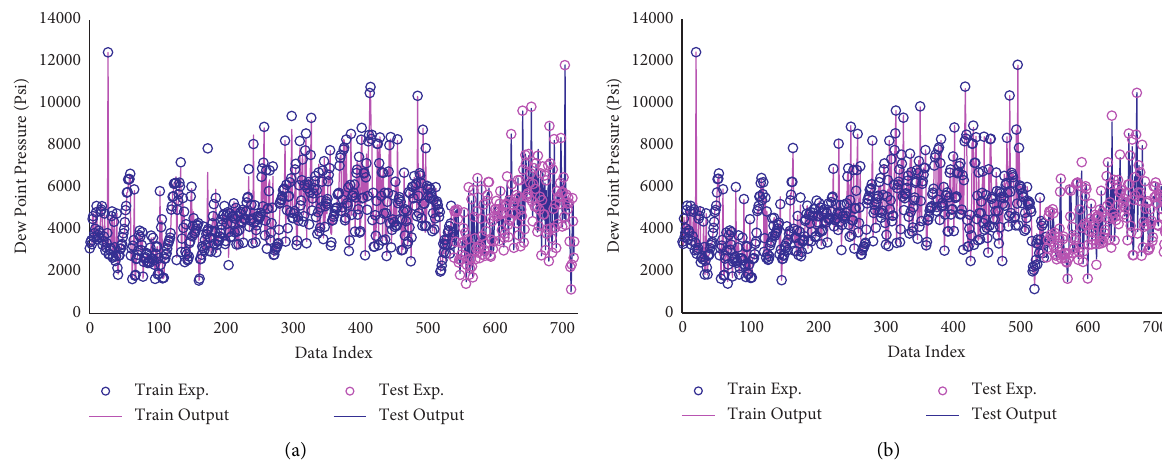
Figure 1: Simultaneous viewing of modeled and real data for (a) PSO-ANN and (b) GA-ANN